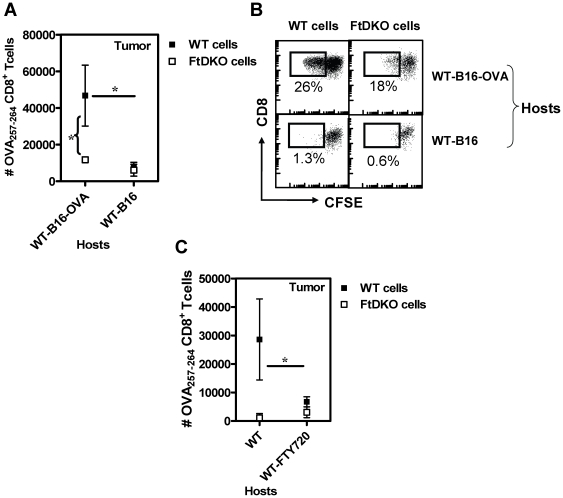
Effect of tumor antigen and lymph node egress in the migration of adoptively transferred antigen-specific CD8+ T cells.Adoptive transfer experiment was carried as indicated in the schematic diagram in Fig. 6A. CFSE-labeled, 1.5×106 OVA257–264-specific CD8+ T cells (obtained from in-vitro expanded cultures) were transferred intravenously into day 9 tumor bearing mice (mean tumor size 45–90 mm2). Mice were euthanized 4 days later and the number of donor cells in the various organs of recipients was enumerated. (A), Mean ± SD (n = 3–5/group) of OVA257–264-specific CD8+ T cells (of WT or FtDKO origin) recovered from the tumor tissue of WT hosts bearing B16-OVA or B16 tumors respectively is indicated. *, WT cells in B16-OVA compared to B16 tumor tissue, p<0.05. *, WT cells versus FtDKO cells in B16-OVA tumor tissue, p<0.05. (B), Representative flow cytometric profile of tumor-infiltrating CD8+ T cells demonstrating CFSE dilution in WT hosts bearing B16-OVA tumors. (C), Mean ± SD (n = 3–4/group) of OVA257–264-specific CD8+ T cells (of WT or FtDKO origin) recovered from the tumor tissue of WT hosts that are untreated on treated with FTY720. *, WT cells in WT hosts compared to WT cells in WT-FTY720 treated hosts, p<0.05.